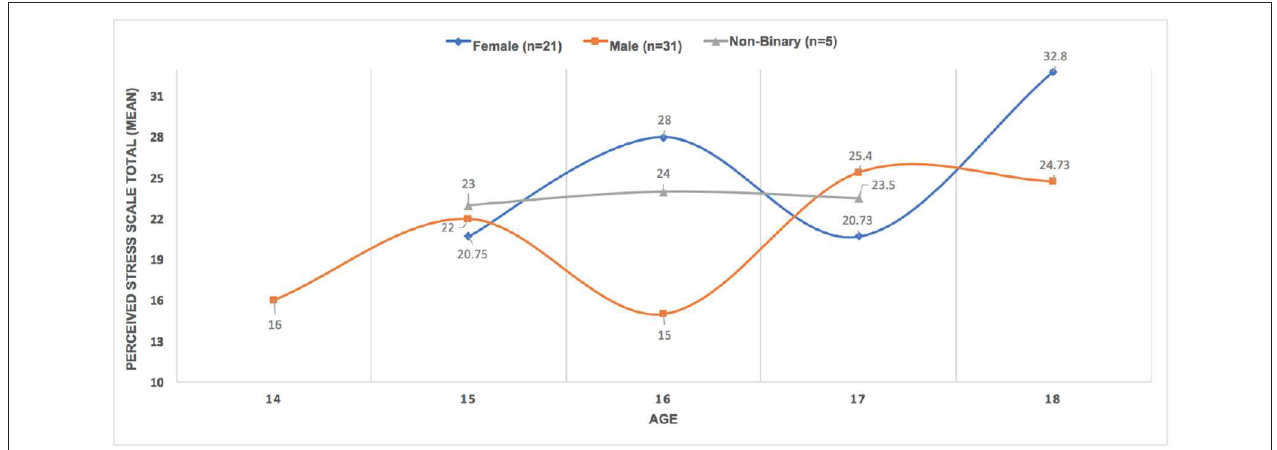
FIGURE 4 | Gender differences in participant mean stress